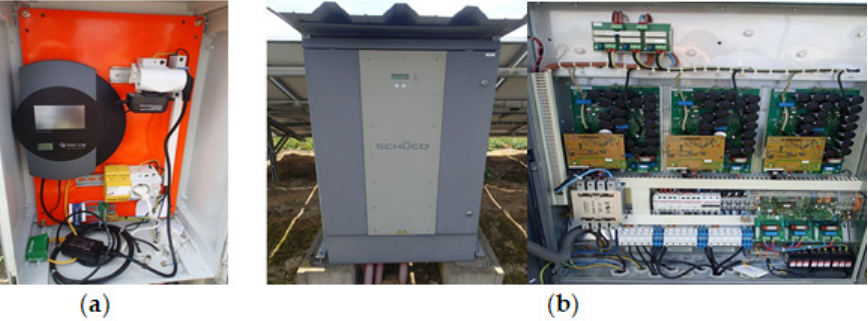
Figure 3. ( a ) Monitoring device: The Solar-Log 2000; ( b ) Voltage converters type Schüco Central Inverter type SGI 33.